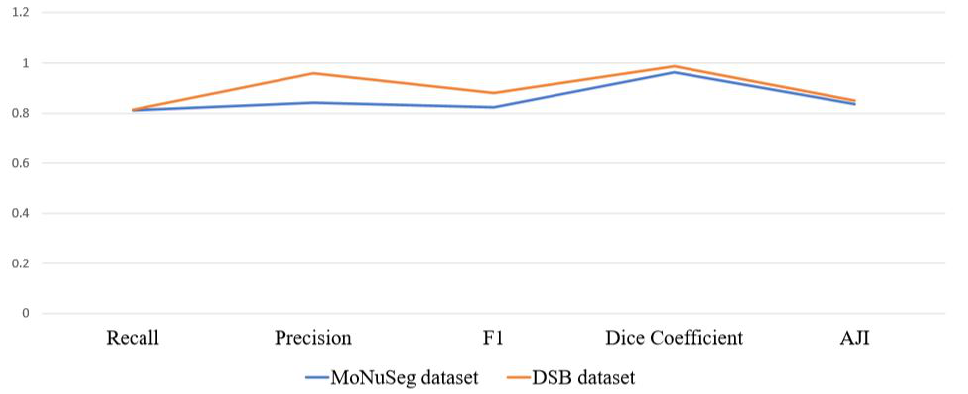
Figure 11. The evaluated indicators for the MoNuSeg and DSB datasets were performed by the proposal.